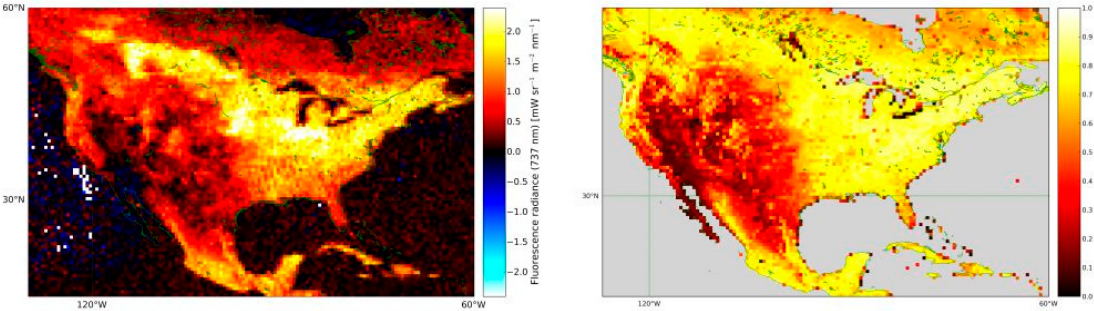
Figure 4. GOME-2A SiF emissions ( left ); and MODIS NDVI ( right ) over North America for July 2013.